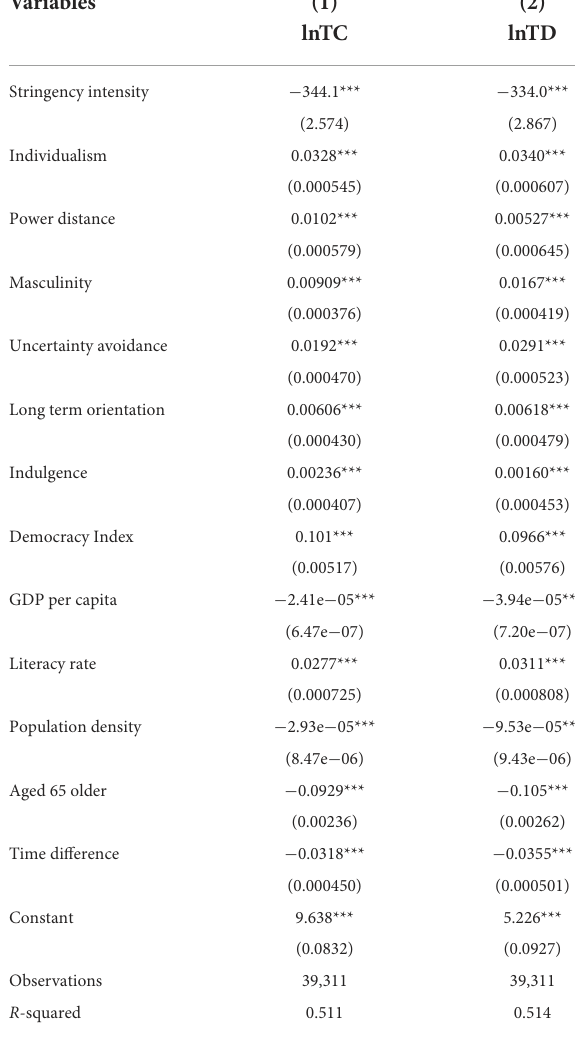
TABLE 8 Impact of 6 culture dimensions on total cases, total deaths, and the mediator.